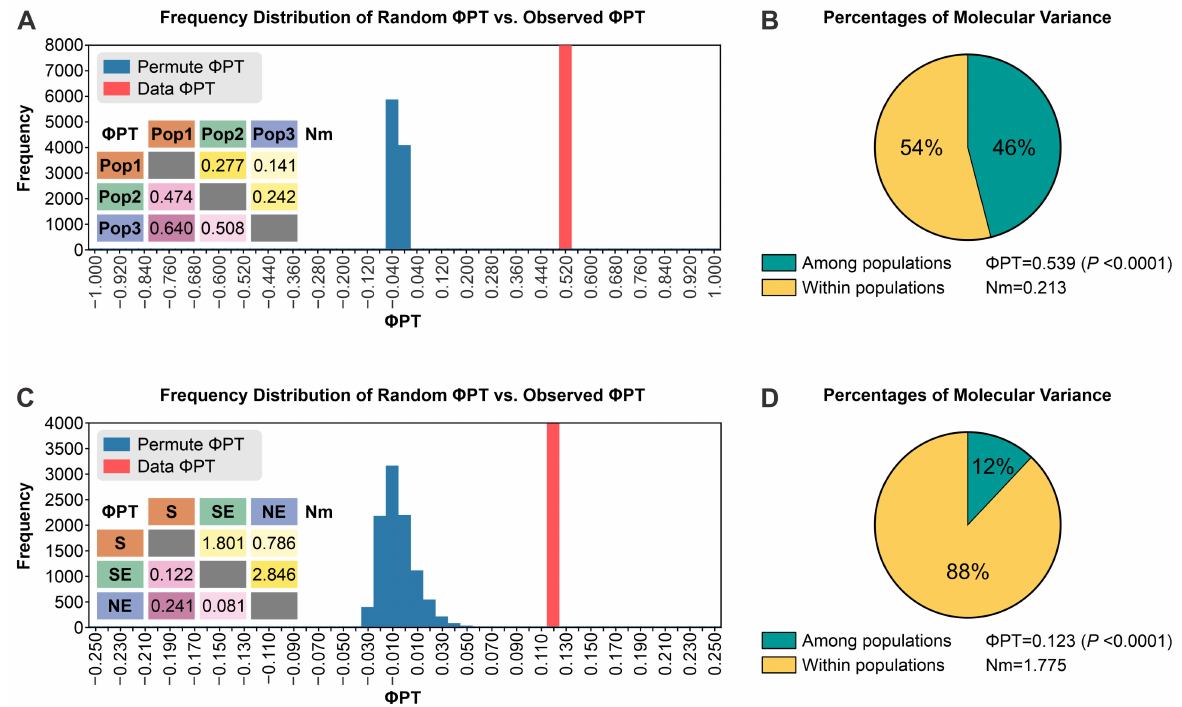
Figure 12. Φ PT genetic distances among medically relevant Sporothrix species based on 15 SSR markers. ( A , C ): Frequency Distribution of Random Φ PT versus Observed Φ PT. ( B , D ): Percentages of molecular variance. ( A , B ): Group Sporothrix (n = 180); Pop1 is 97 S. brasiliensis isolates; Pop2 is 49 S. schenckii isolates; Pop 3 is 34 S. globosa isolates . ( C , D ): Group Sporothrix brasiliensis (n = 96). The most significant Φ PT values were found between the South (S) and Northeast (NE) S. brasiliensis isolates ( Φ PT = 0.241), along with the lowest Nm values (0.786). The lowest values were found in pairwise comparisons between the Southeast and Northeast, demonstrating the proximity of these isolates ( Φ PT = 0.081) and suggesting that the migration occurred between members of the southeastern region and the northeastern region of Brazil. S: S. brasiliensis South isolates (n = 18); SE: S. brasiliensis Southeast isolates (n = 67); NE: S. brasiliensis Northeast isolates (n = 11). Isolate Ss104 from Central-West Brazil was removed from the S. brasiliensis dataset. Nm is gene flow.